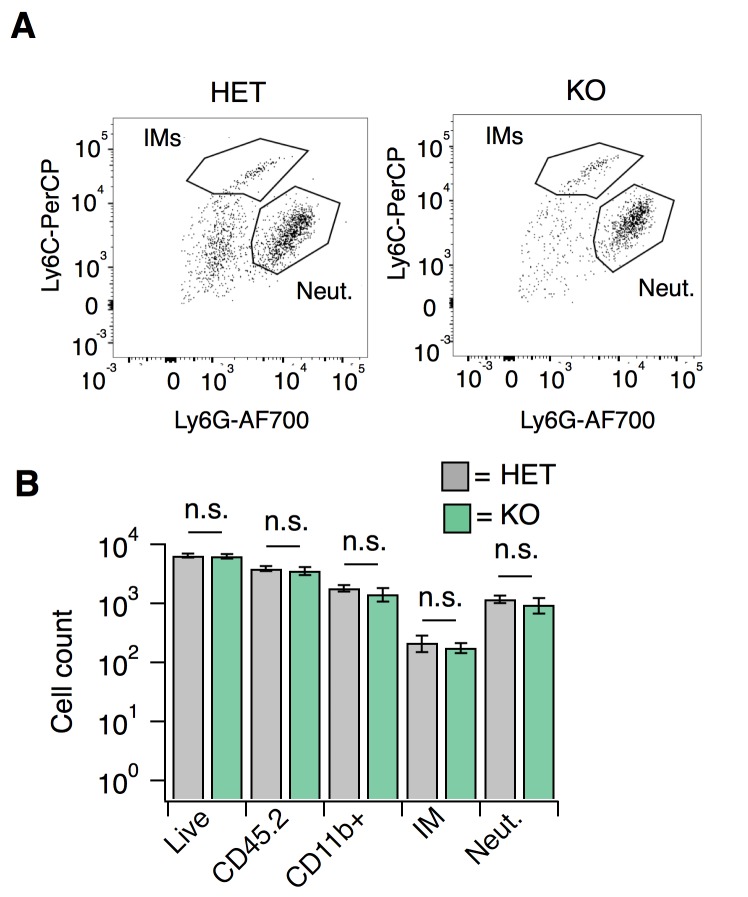
S1PR3 KO animals display normal CFA-evoked immune cell recruitment.Related to Figure 7. (A) Recruitment of neutrophils (Neut.) or inflammatory monocytes (IMs) to hindpaw skin 24 hr post-CFA administration in S1PR3 HET and KO mice, as a dot plot of CD11b + cells plotting Ly6G fluorescence intensity vs. Ly6C intensity (AFU). Boxes are for illustrative purposes. (B) Recruitment of immune cells, including neutrophils (Neut.) and inflammatory monocytes (IMs) to hindpaw skin 24 hr post-CFA administration in HET and KO mice, displayed as total number of cells; N = 8 mice per genotype. Sidak’s multiple comparisons were made between HET and KO for each cell type.